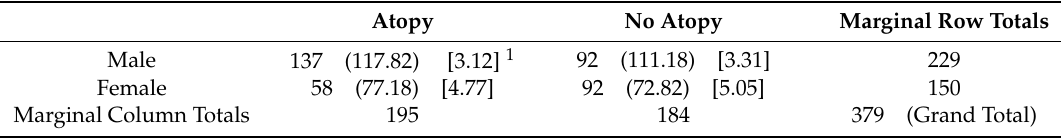
Table 7. Relationship between atopy and sex in athletes with